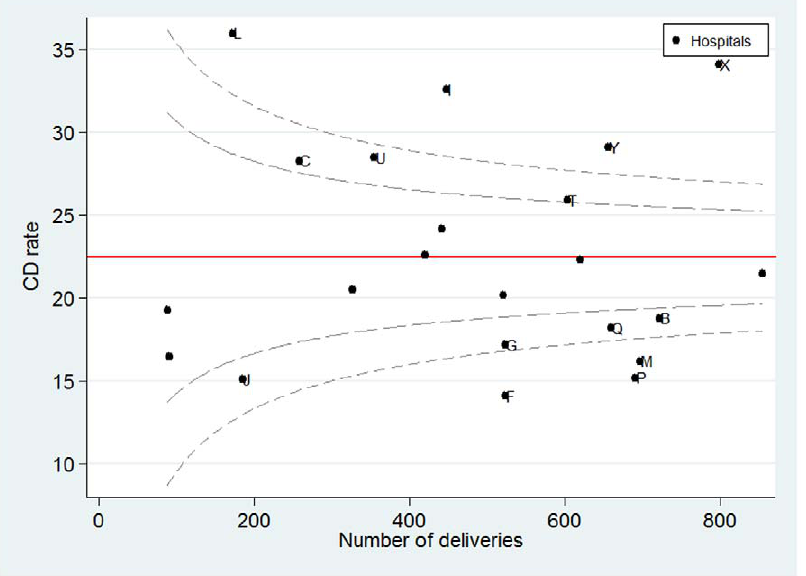
Figure 1. Funnel plot showing the relationship between the number of deliveries and NTCS CD rates in the hospitals of Tuscany. Dashed lines indicate the 95% and 99.8% CI for the CD rates.